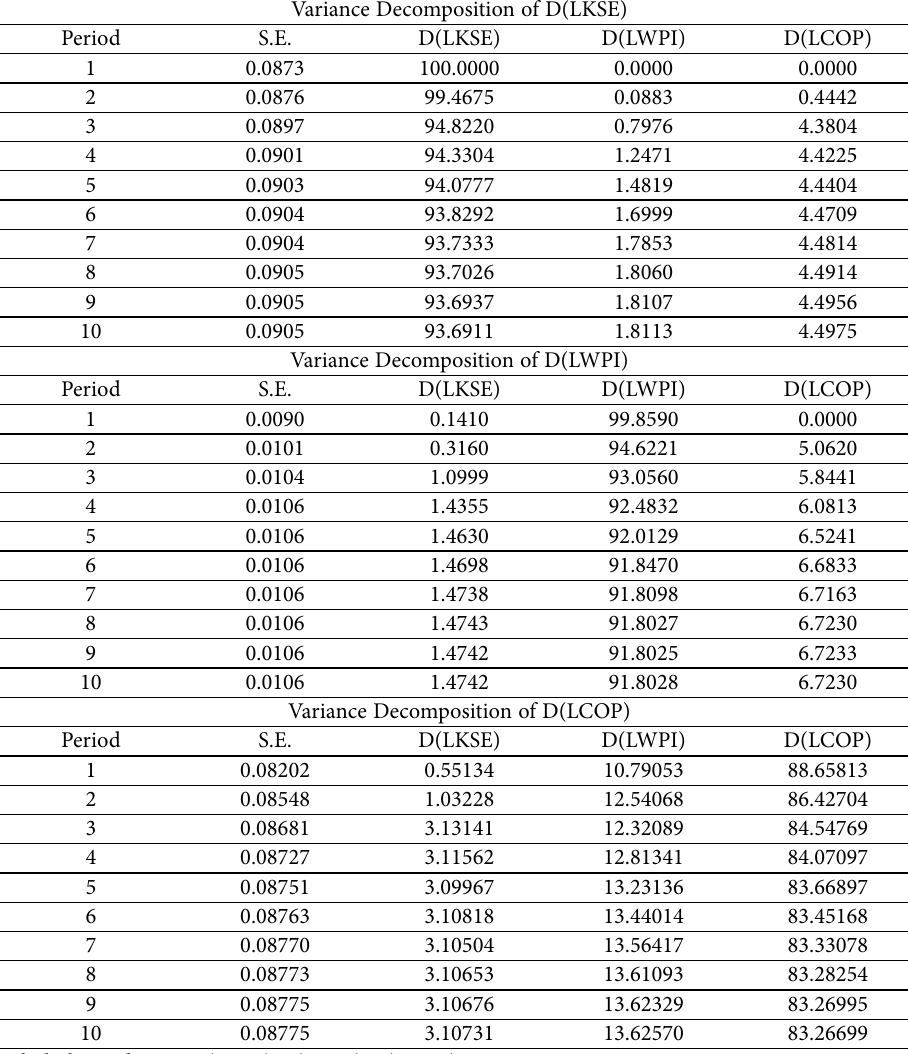
Table 7. Variance Decomposition – D(LKSE), D(LWPI) &